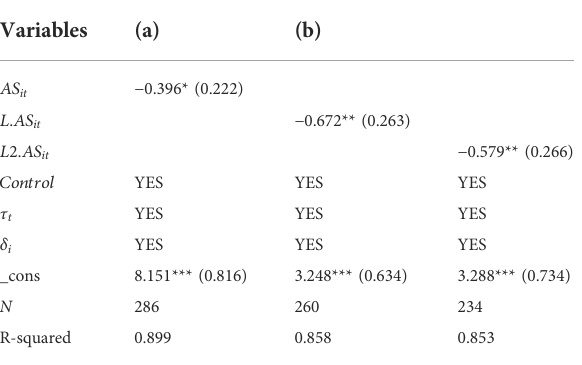
TABLE 6 Robustness tests.